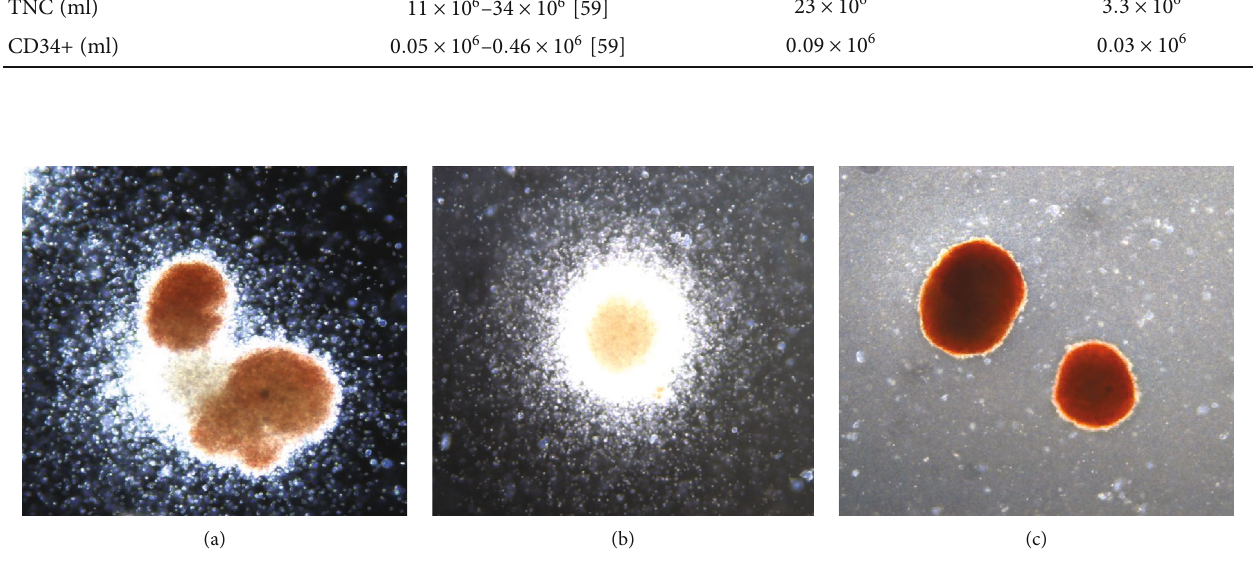
Figure 2: Stem cell colonies grown from the bone marrow from research-consented deceased donors: (a) CFU-GEMM (10x), (b) CFU-GM (10x), and (c) BFU-E